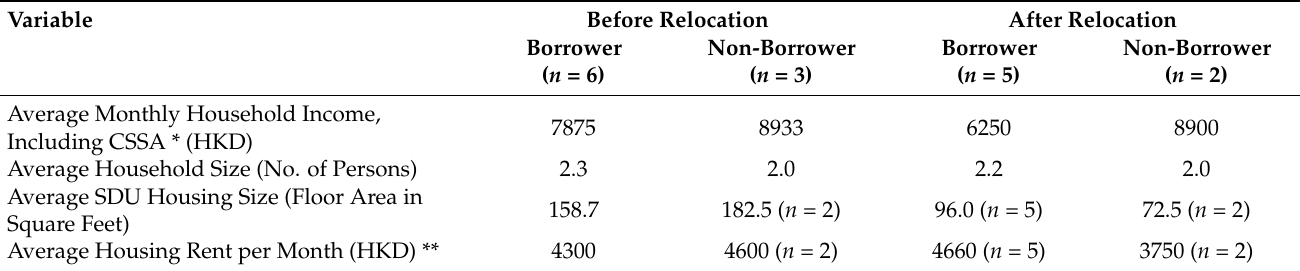
Table 1. Respondents’ household and housing characteristics before and after